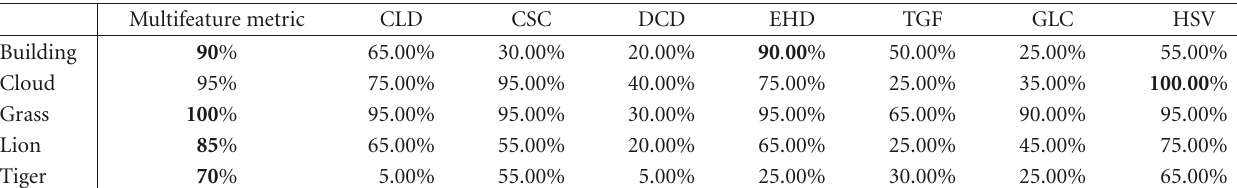
Table 3: Precision values for the first page of retrieved images with a threshold of 50.